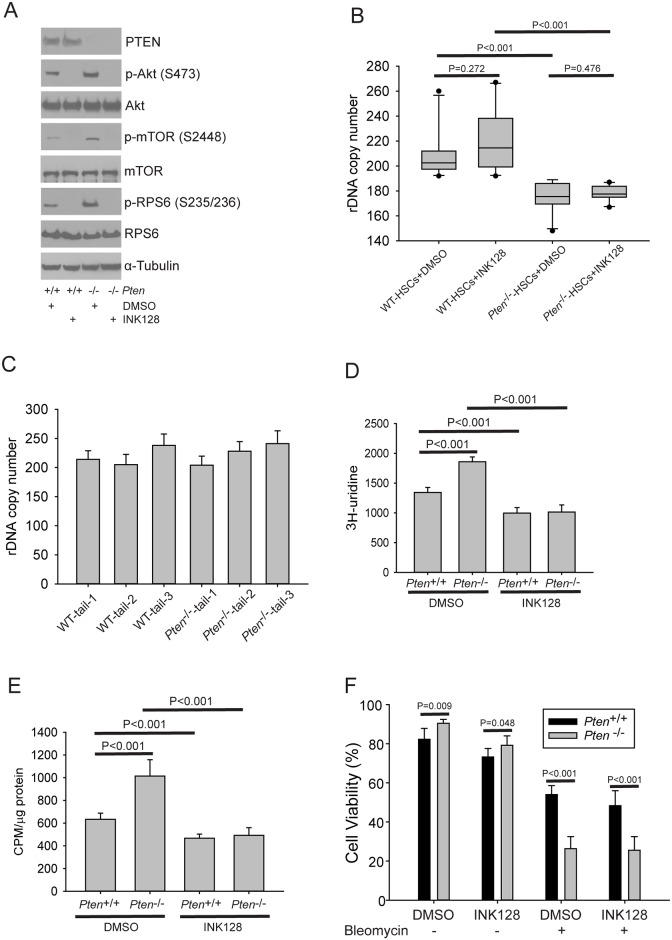
Pten-/- HSCs are sensitive to DNA damage when mTOR activity is blocked with INK128.A. Western blot confirming that INK128 treatment (300 nM) blocks mTOR activity in HSCs after 5 days. All HSCs are derived from three age matched males of each genotype. B. Pten-/- HSCs exhibited a decrease in rDNA copy number compared to matched WT HSCs, samples were derived from three males of each genotype with 10 clones total, 3 from 2 mice and 4 from the third. (C). The rDNA copy number in the mouse tail gDNA samples was similar between individuals, and was also similar to rDNA copy number in WT HSCs. (D) for D-F, Six independent HSC clones were used per condition, two from each mouse. 3H-uridine incorporation was measured after 2 hours of labelling as described in Fig 6B. E. Protein synthesis was measured as described in Fig 6C. F. HSCs were pretreated with INK128 for 2 hrs prior to the addition of bleomycin. INK128 or DMSO and bleomycin were maintained in the culture for the duration of the experiment. Viability was calculated at day five based on total cell number and trypan blue staining.